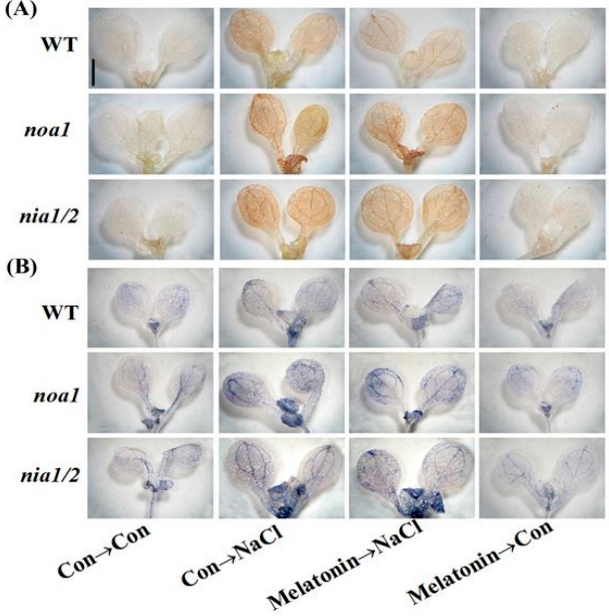
Figure 11. Genetic evidence revealed that redox balance was reestablished by melatonin via NO. Five-day-old wild-type (WT), noa1 , and nia1/2 mutant plants were grown on MS medium supplemented with 1.0 μ M melatonin for 5 days, and then transplanted to medium in the presence or absence of 125 mM NaCl for another 5 days. Control seedlings (Con) were grown in MS medium alone. Afterwards, seedlings were stained with DAB ( A ) and NBT ( B ) to detect H 2 O 2 and O 2 − . Scale bar = 1 mm.